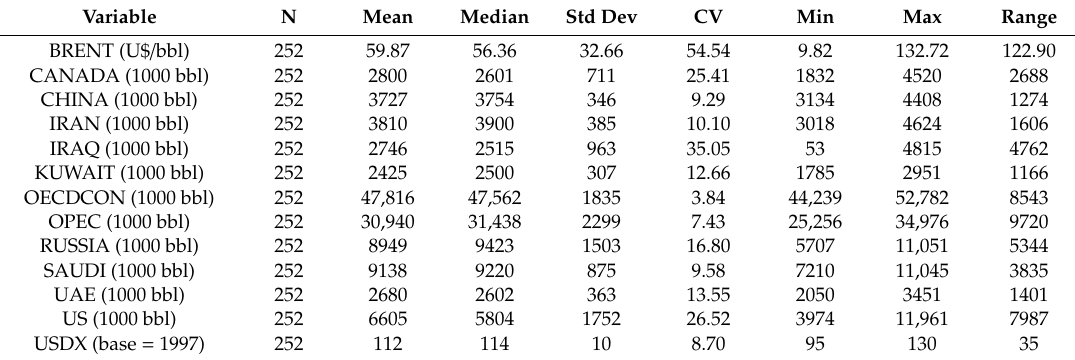
Table 1. The whole period (1998–2018): summary